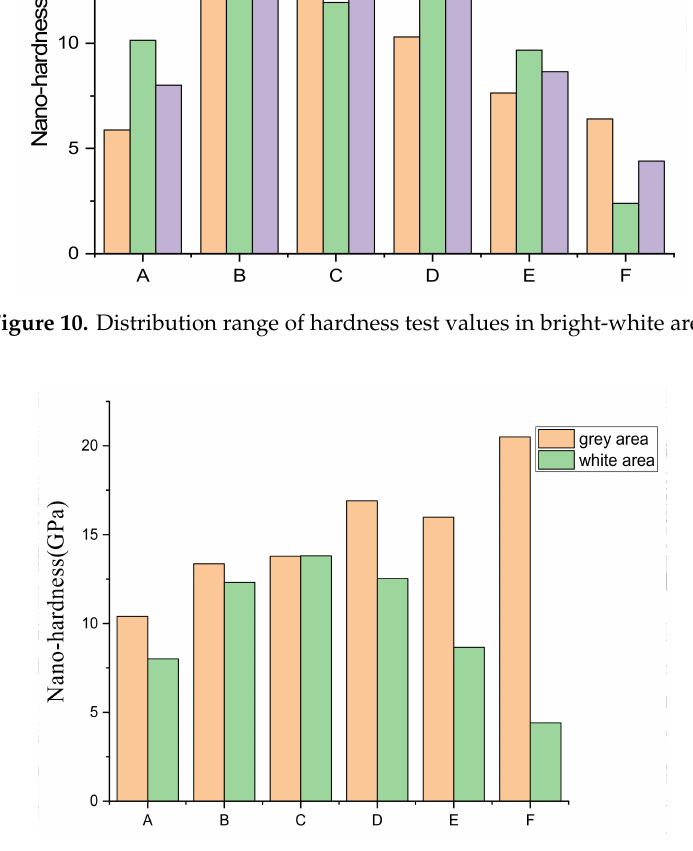
Figure 11. Nano-hardness of calcined bauxite samples